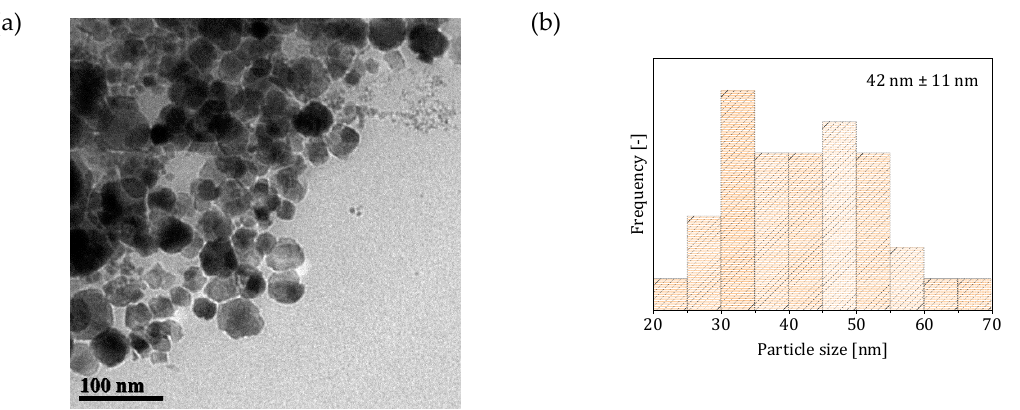
Figure 3. ( a ) TEM micrograph and ( b ) particle size distribution of particles obtained from Reactor System 2.